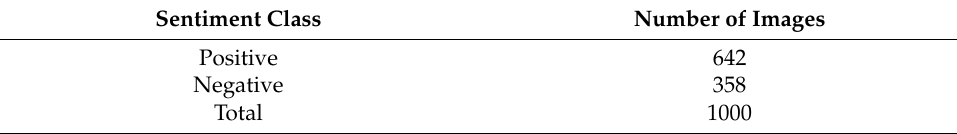
Table 4. Input image database details.